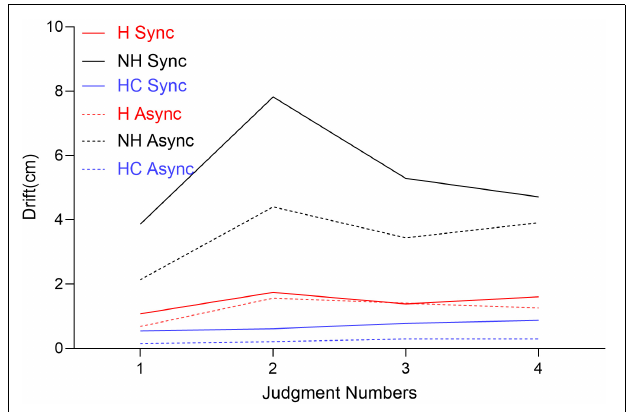
FIGURE 1 | Line graph to show the change in the proprioceptive drift of patients and healthy controls (HCs) over time. Judgments were taken at 1 min